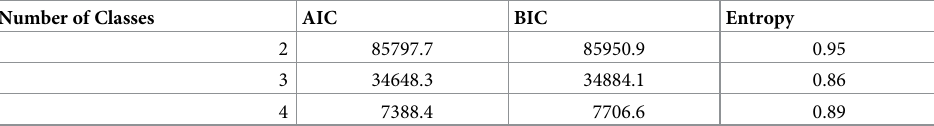
Table 1. Indicators of fit for latent class analysis with two through four classes of emission exposures. Number of